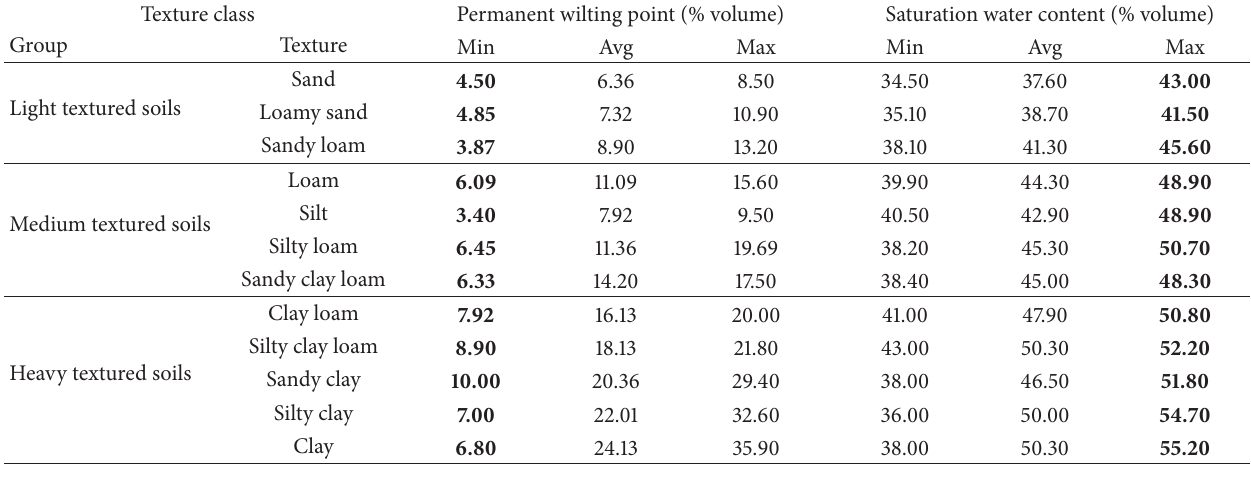
Table 3: Soil hydraulic properties according to its texture from the literature SRC: ElNesr